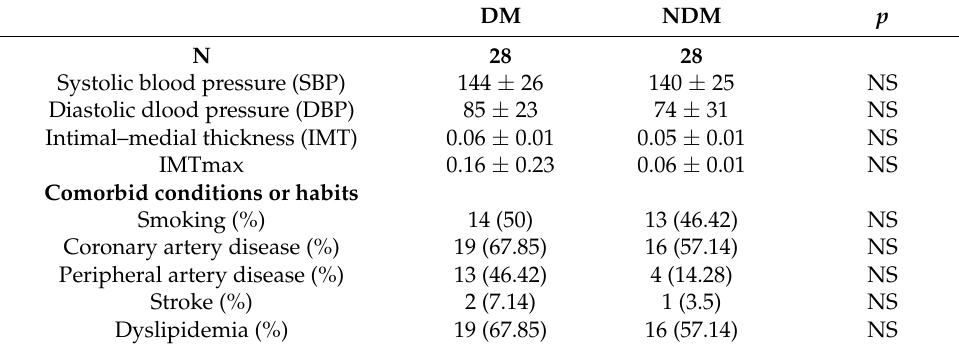
Table 1. Clinical characteristics of diabetic (DM) and nondiabetic (NDM) patients at